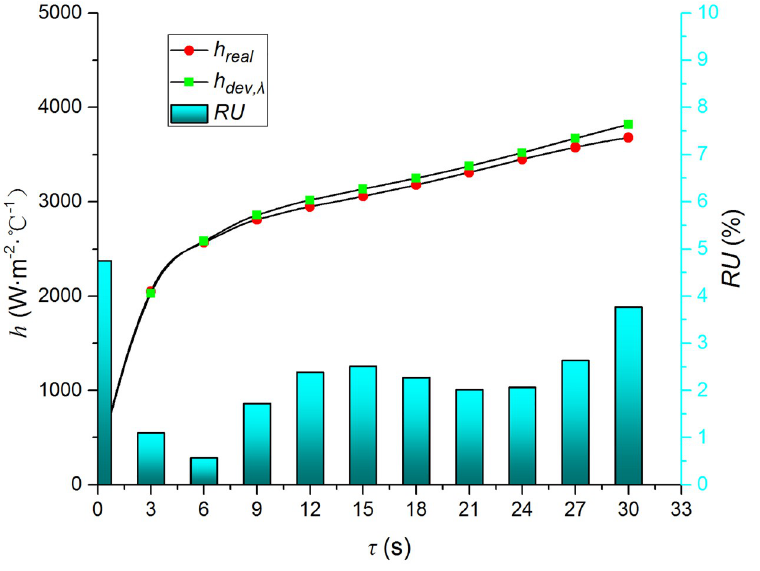
Fig 12. Comparison of h dev , λ and h .